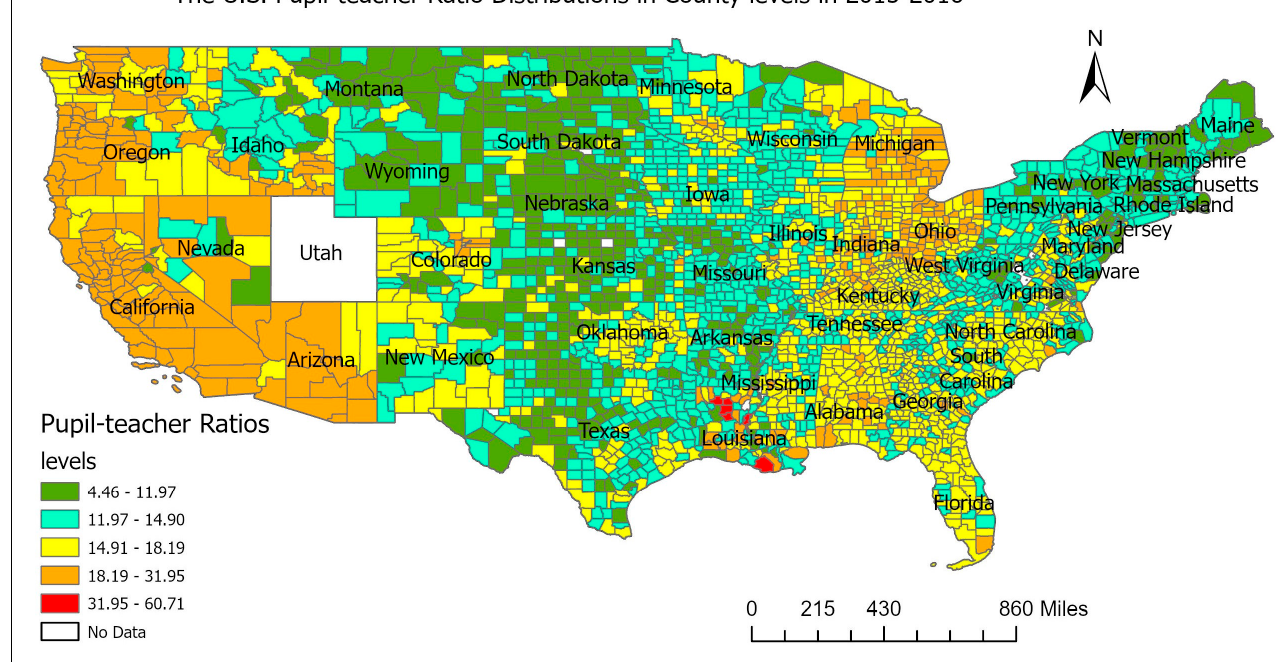
Figure 6. Student–teacher ratio displayed at county level.